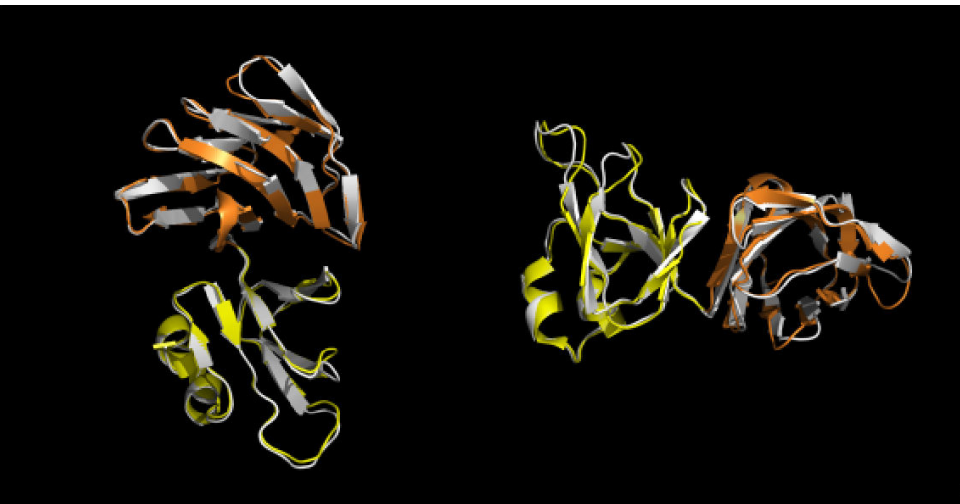
Figure 3. Close-up superimposition of S. solfataricus MalA C (yellow) and D (orange) domains and Aglu1 model